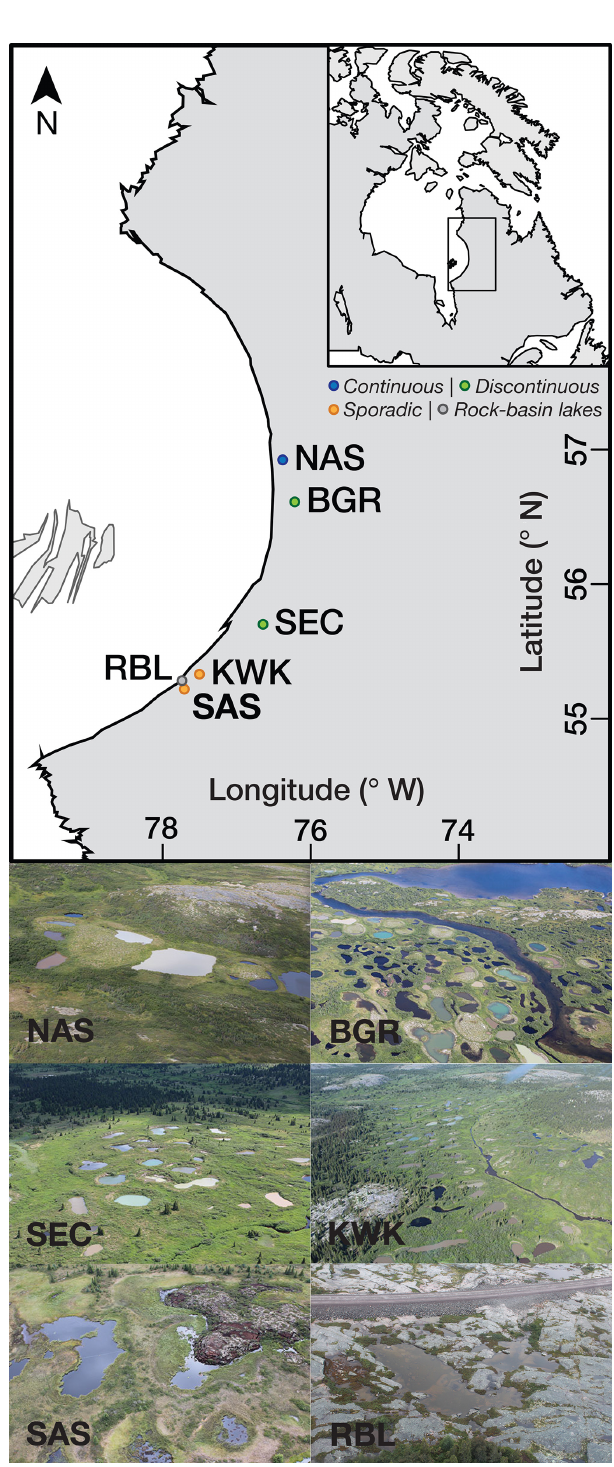
Figure 1. Map of the study region and photos of the six study